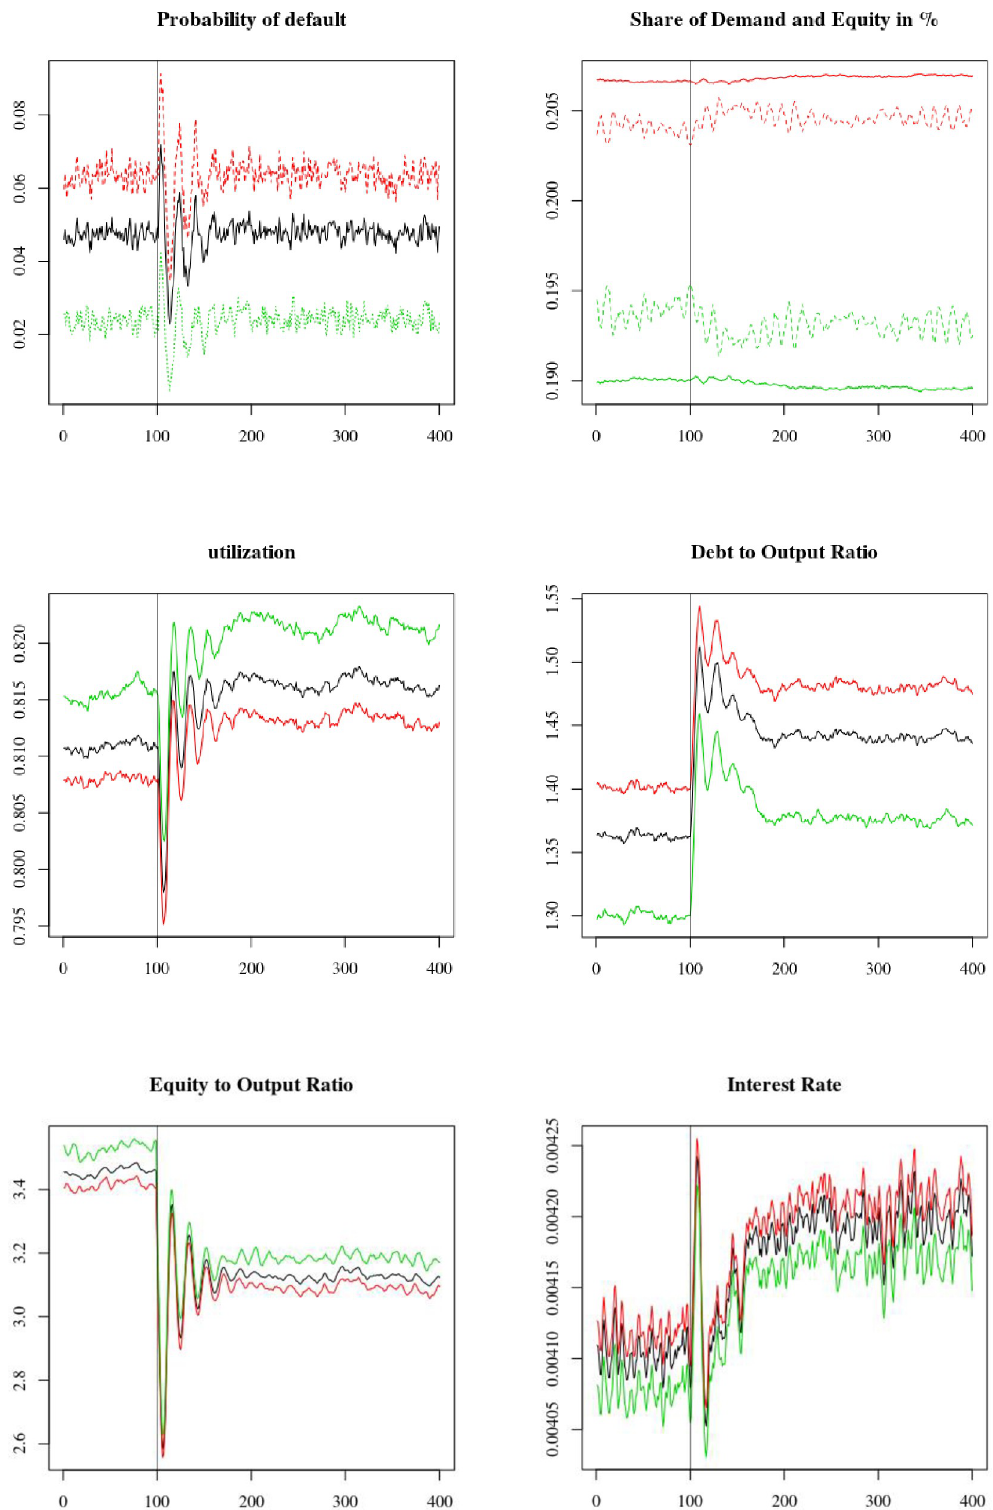
Fig 7. Run to liquidity: Increase in the parameter σ T neutral firms (green).